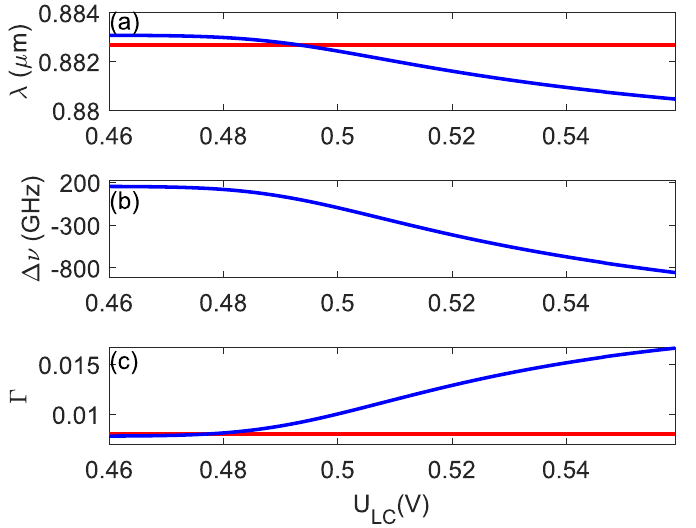
Figure 4. Dependences on the voltage U LC applied to the LC of: ( a ) Wavelengths of the LC-VCSEL resonant longitudinal modes polarized along Ox (red lines) and along Oy (blue lines); ( b ) Differ- ence between the frequencies of these resonant modes and ( c ) QW confinement factors of these resonant